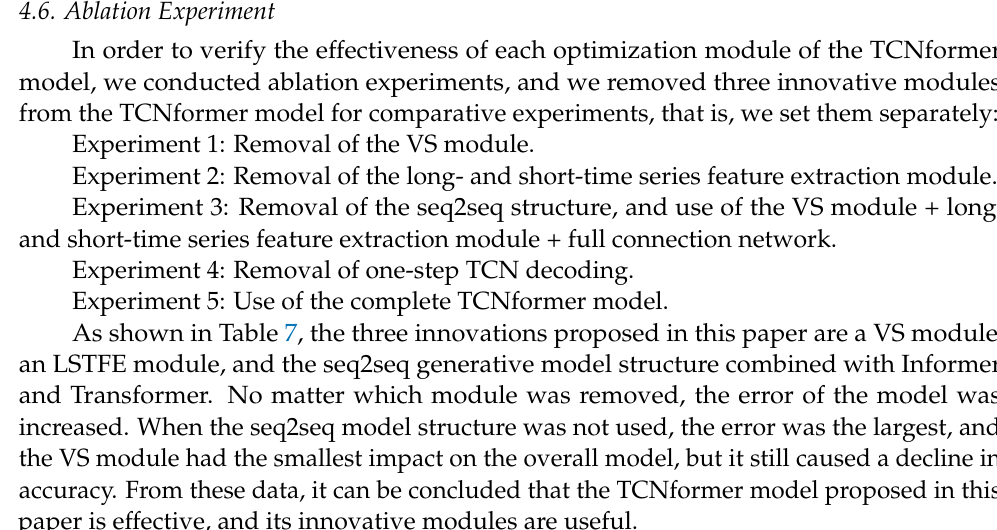
Table 7. Results of ablation experiment.